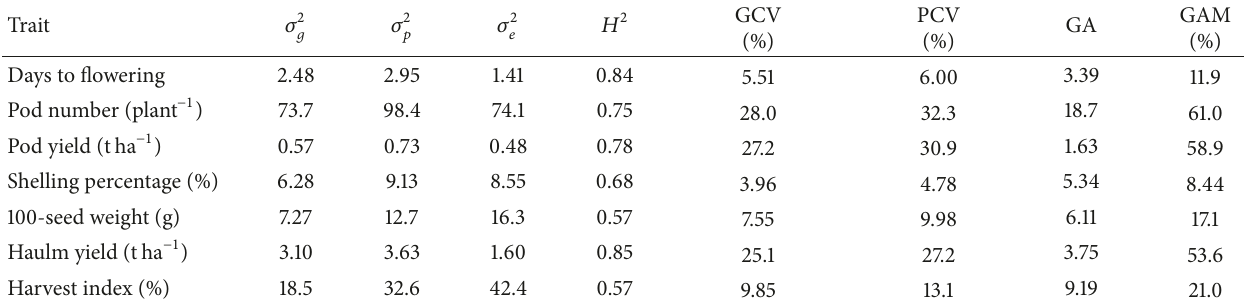
Table 3: Estimates of variance components, heritability, coefficient of variation, and genetic advance of 30 groundnut genotypes.